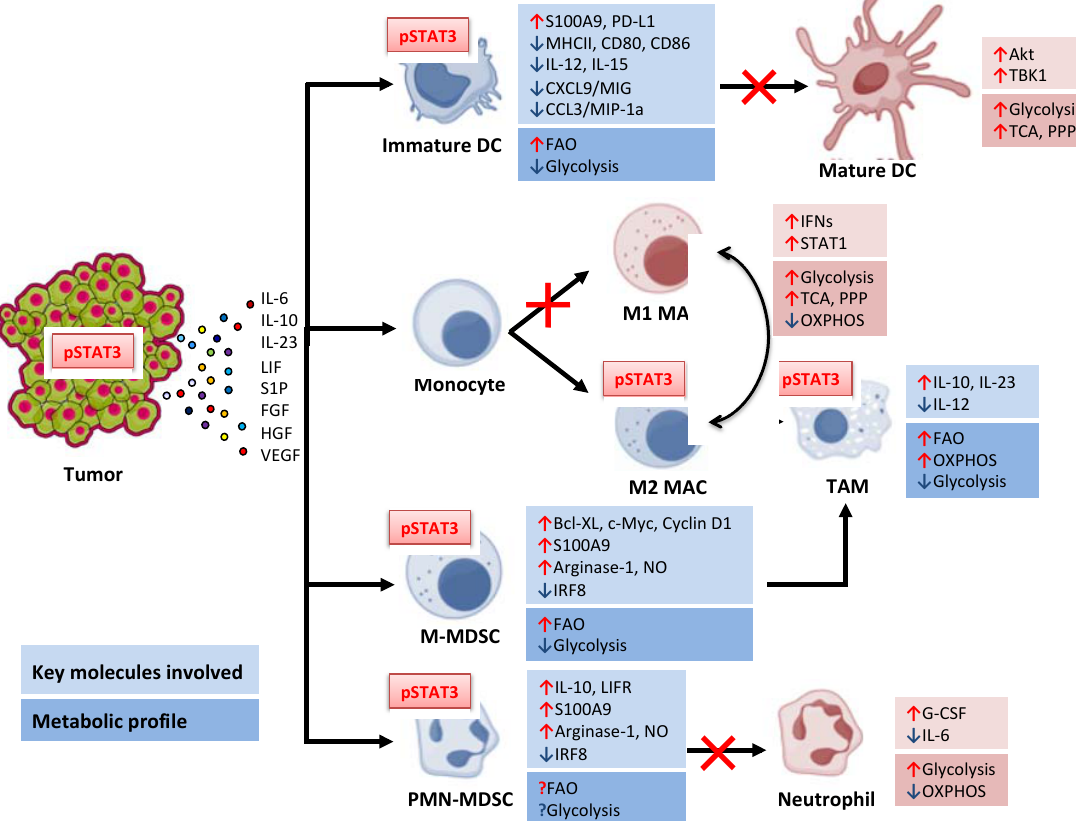
Figure 1. Effects of the tumor microenvironment on myeloid cell differentiation and metabolism. The black arrows indicate the developmental pathway of myeloid cell differentiation. In the presence of tumor ‐ derived factors, the normal developmental pathways to mature DCs, M1 macrophages, or neutrophils are deregulated as indicate by red crosses. These processes result in the accumulation of immature DCs, tumor ‐ associated macrophages, and undifferentiated polymorphonuclear (PMN) ‐ and monocytic(M) ‐ MDSCs. The red and blue arrows indicate up ‐ or down ‐ regulated key molecules and metabolic profiles, the question marks indicate those remain unknown.